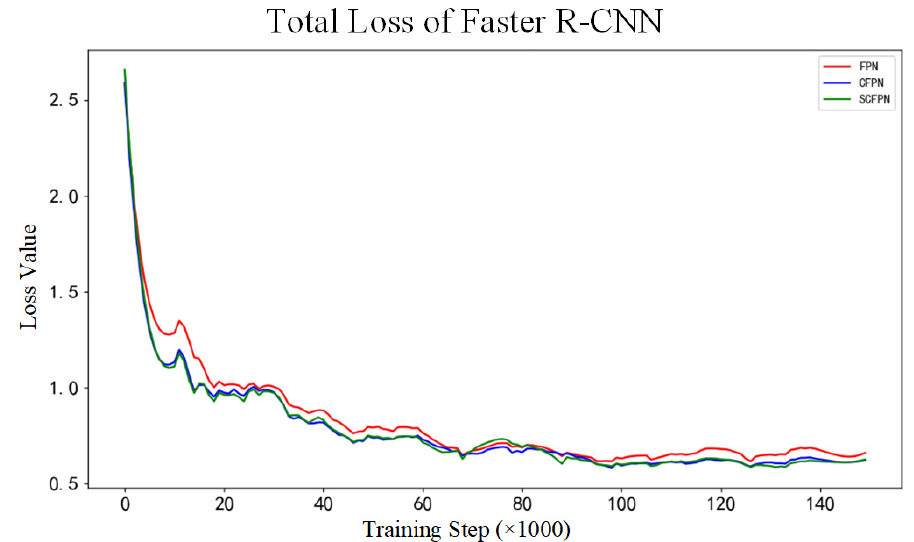
Figure 6. Total loss of Faster R-CNN. Red: FPN; blue: CFPN; green: SCFPN.